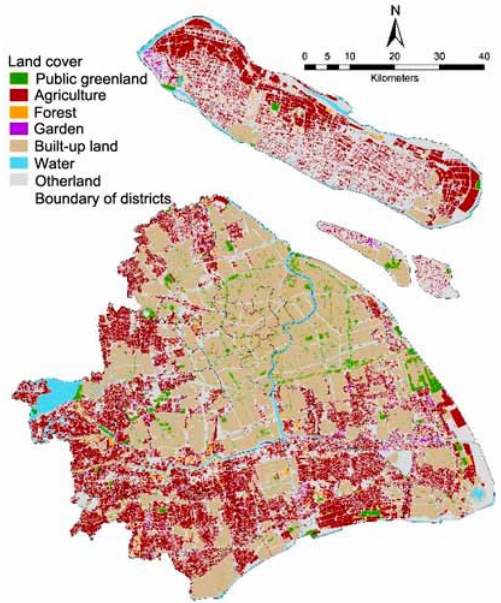
Fig. 3. Land use distribution in Shanghai